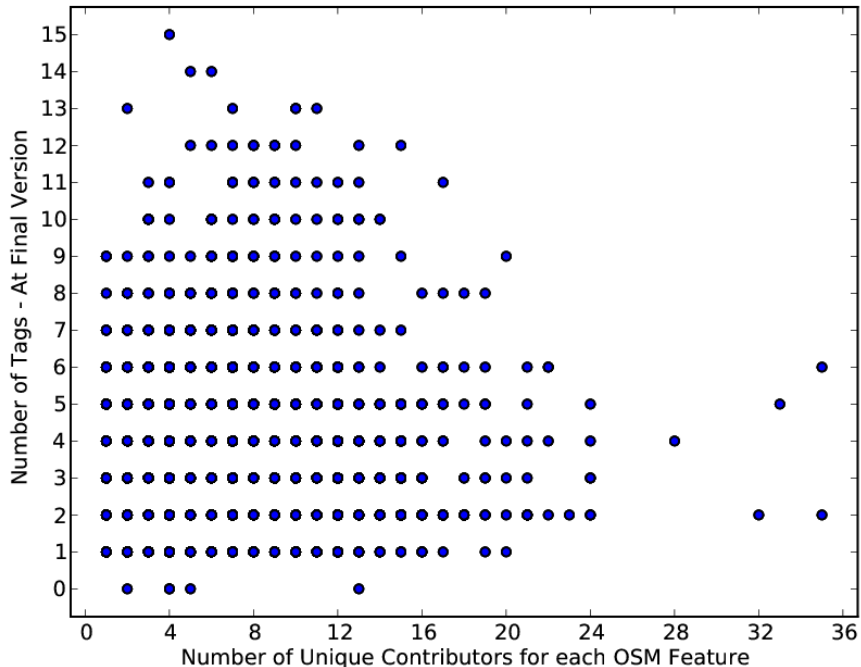
Figure 5. Scatter plot of the number of tags against the number of contributors for all objects in the case study